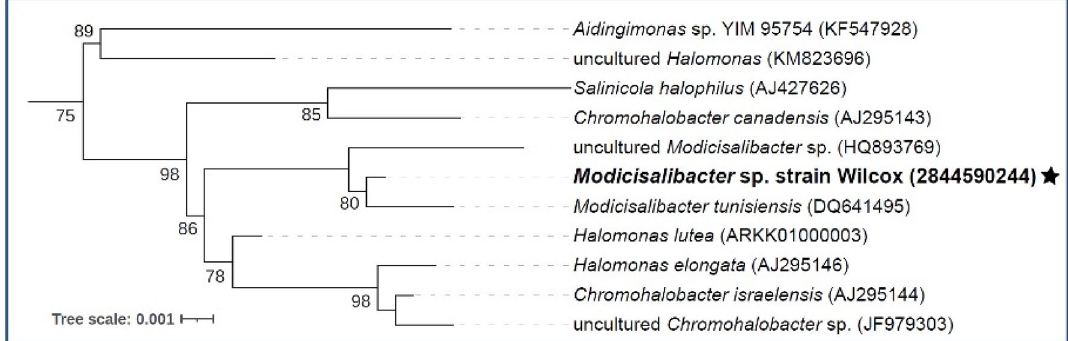
Figure 1. FastTree maximum likelihood approximation phylogenetic tree of 16S rRNA gene sequences of Wilcox and its most closely related phylogenetic neighbors. Only bootstrap values above 75% are shown. Integrated Microbial Genomes (IMG) Gene ID is provided for strain Wilcox, indicated by a star. Silva database accession numbers are included for all other sequences. The tree was constructed using the Alignment, Classification and Tree Service hosted at the SINA website 23